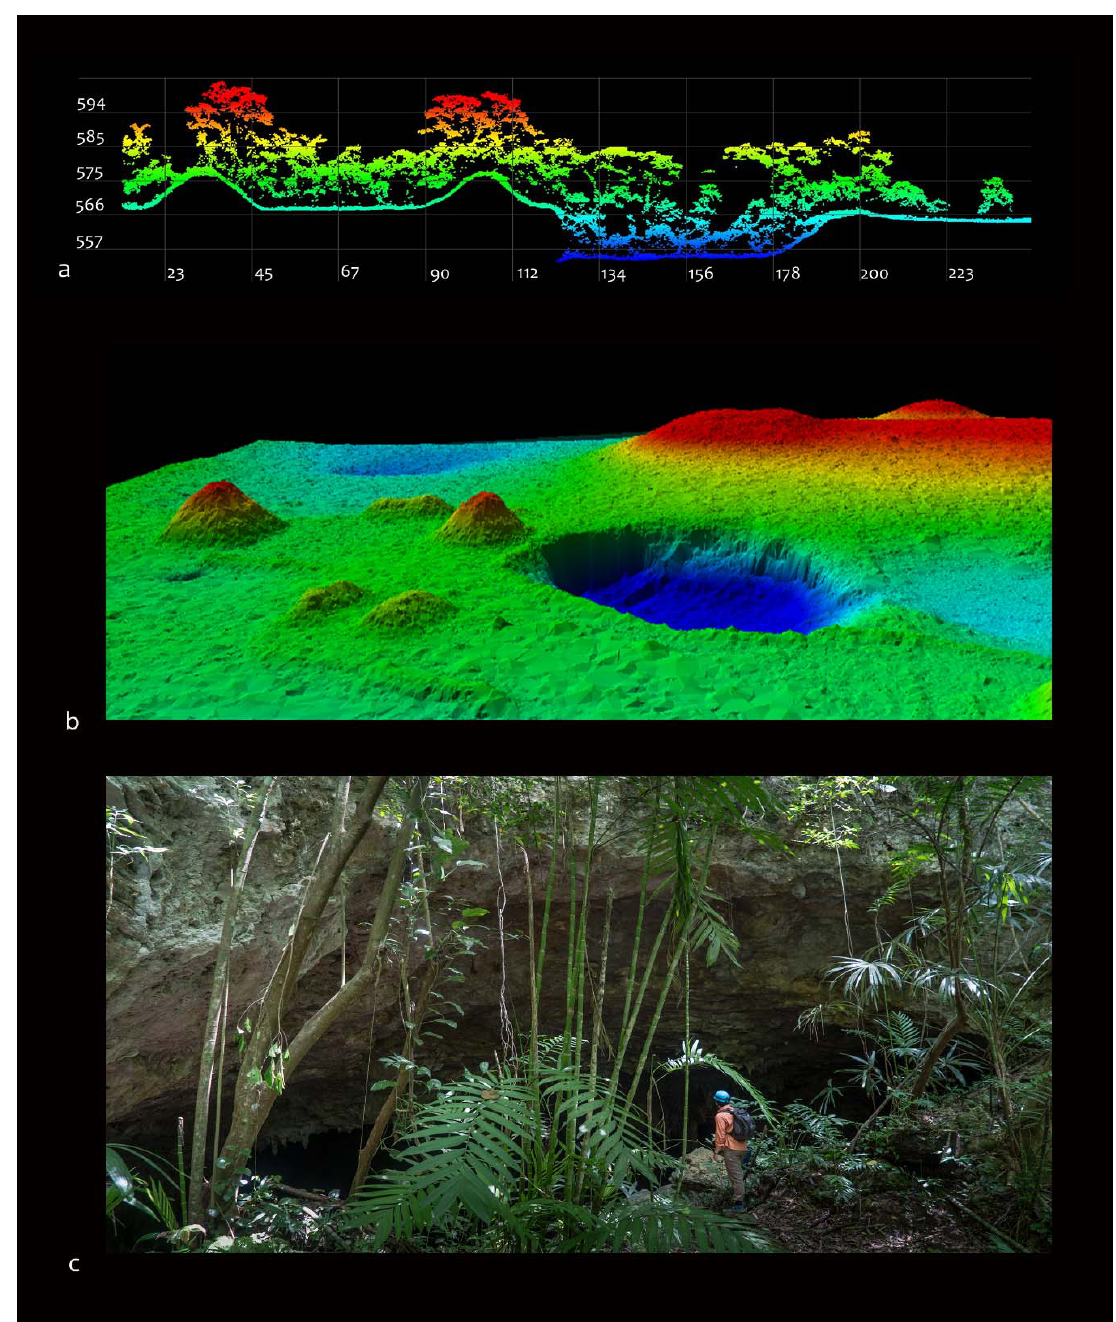
Figure 12. Las Cuevas surface site and sink hole: ( a ) point cloud of cave and sinkhole viewed from the north using LP360, ( b ) 3D image of sinkhole and surface structures (LP360), ( c ) photo of large Las Cuevas cave entrance (courtesy of LCAR).